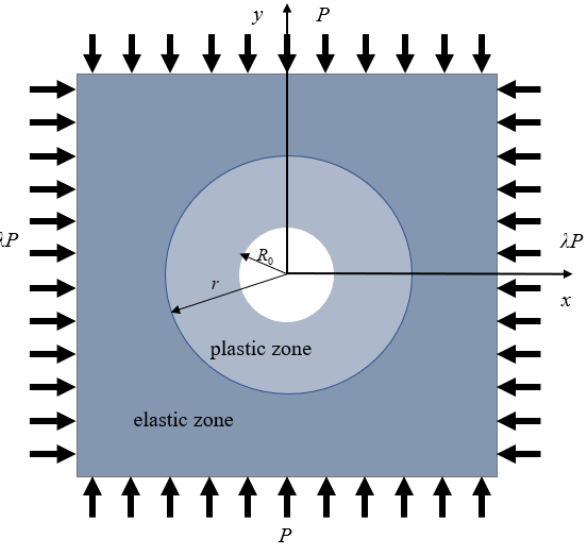
Figure 1. Circular roadway surrounding rock force model in the inhomogeneous stress field.